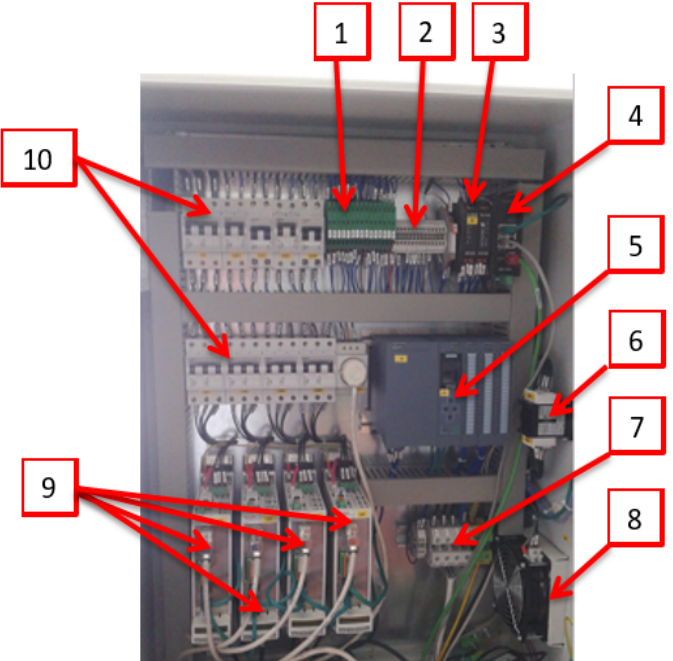
Figure 11. The command-and-control panel, with the included software component, of the MMI4D system. Legend: 1—24V fuses; 2—34V connection clamps; 3—controller’s gripper; 4—the communications module SECCOMAT; 5—Programmable Logic Controller (PLC); 6—general power supply switch; 7—connecting clamps for the X, Y, Z and R axis control cables; 8—cooling fan; 9—modules for controlling linear and rotating electrical systems; 10—the thermal protection voltage circuit breakers.